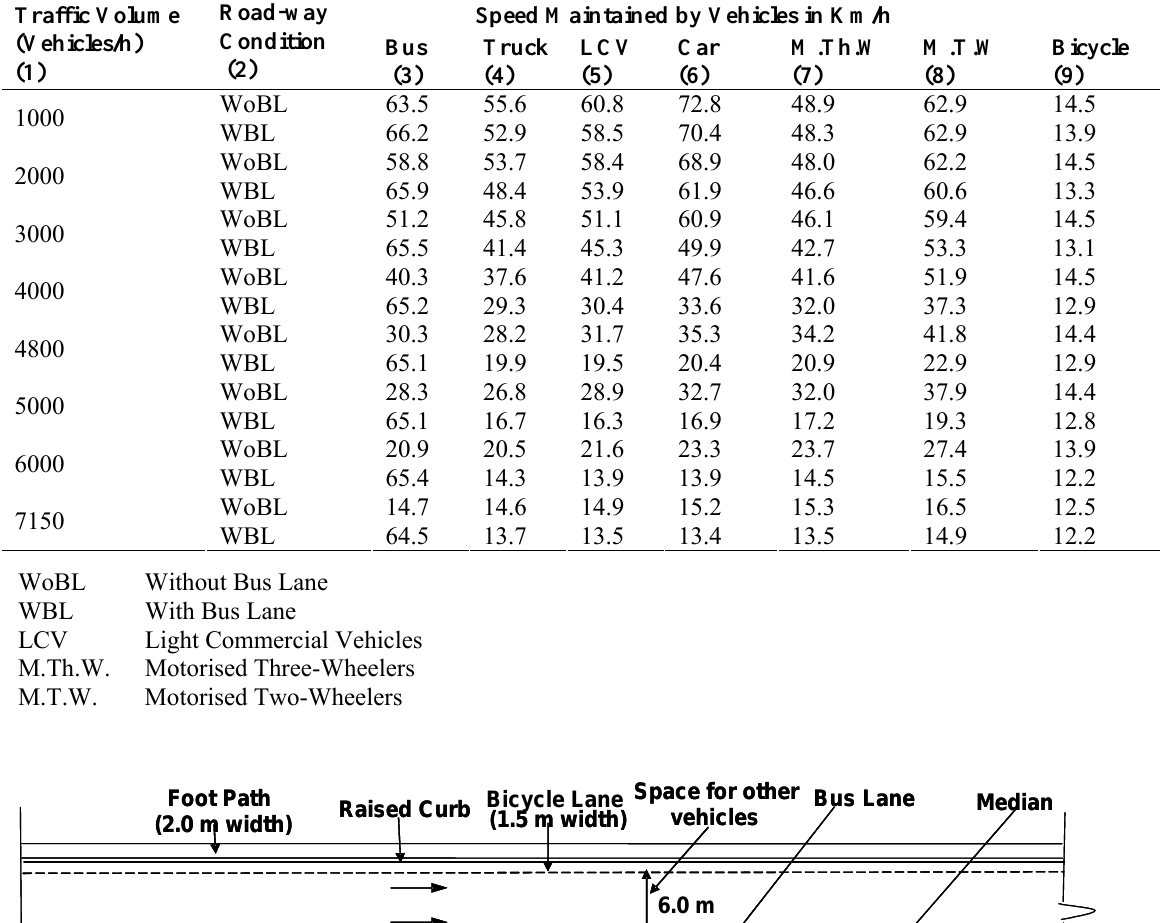
Speed Maintained by Vehicles in Km/h Traffic Volume